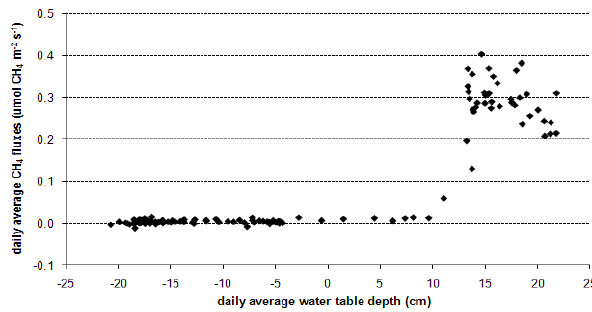
Fig. 4. Relationship between CH 4 fluxes and depth of the water table.